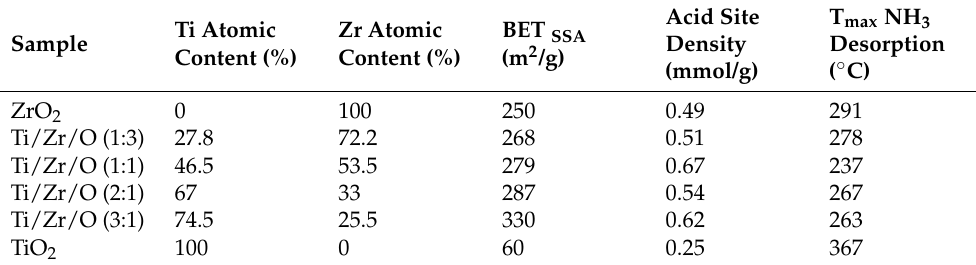
Table 1. Atomic content, surface and acid properties based on strength and acid site density for the Ti/Zr/O synthesized catalysts, using XRF, BET and TPD-NH 3 ,